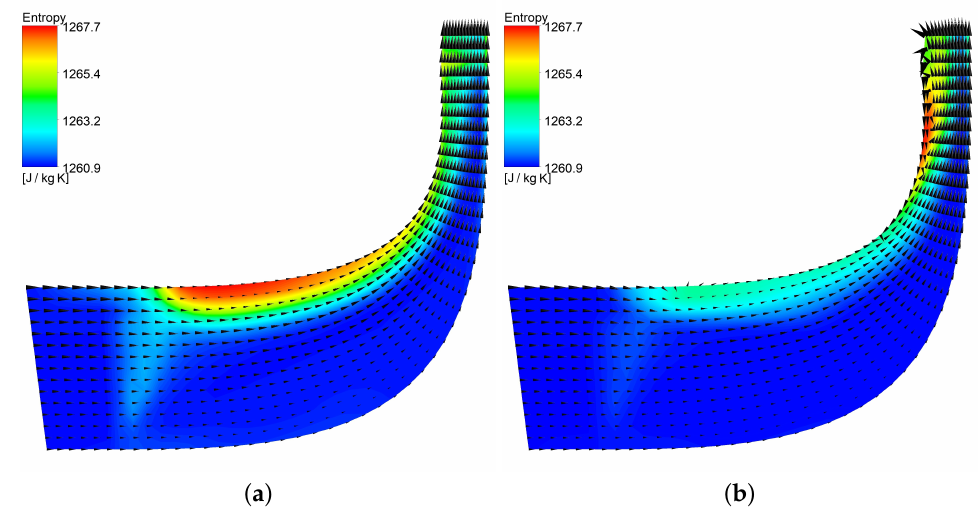
Figure 10. Velocity vector plot on the meridional plane with mass flow rate averaged entropy at a mass flow rate of 4 kg/s. The flow at the outlet section is uniform in impeller without tip clearance configuration, while it becomes a wake flow in with tip clearance configuration. ( a ) Impeller without tip clearance. ( b ) Impeller with tip